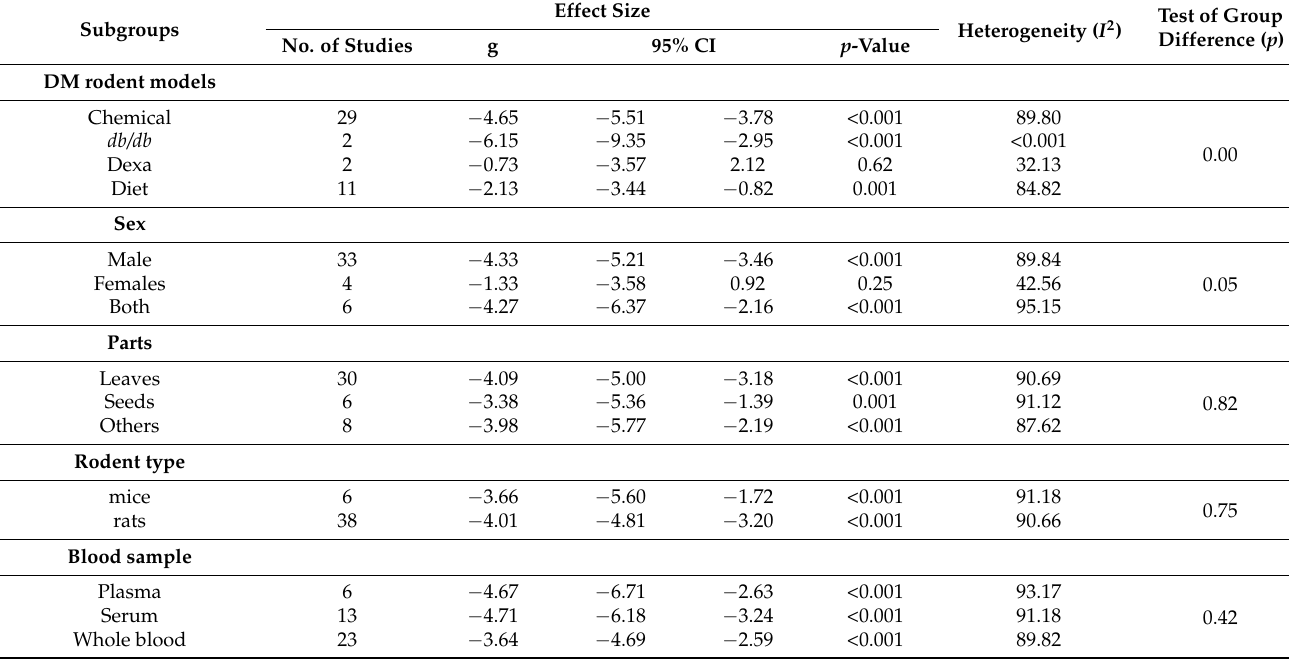
Table 2. Subgroup analyses of blood glucose